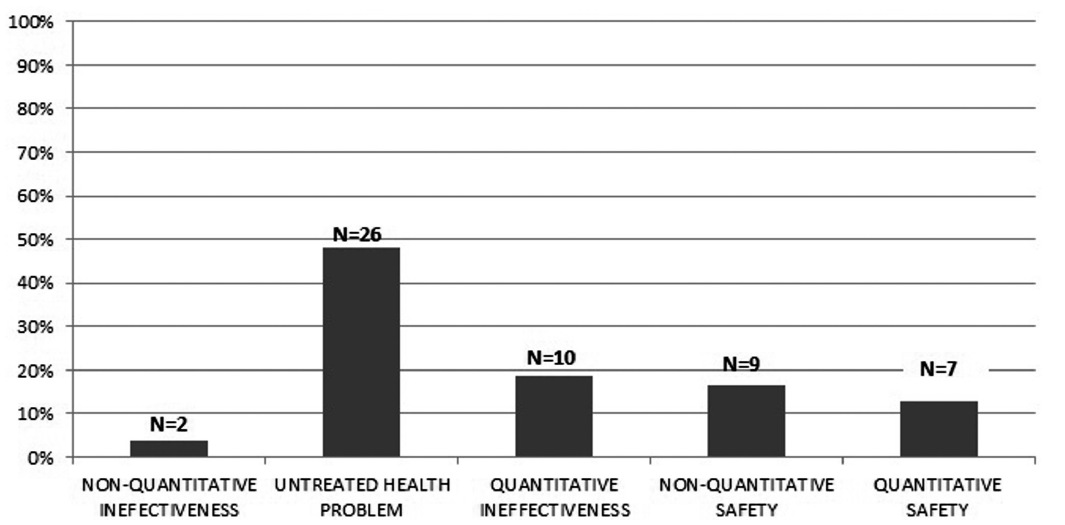
FIGURE 2 - Negative Outcomes associated with Medication (NOM) identified by the Pharmaceutical Care Service for kidney and liver transplant patients. April – October/2011, Fortaleza –